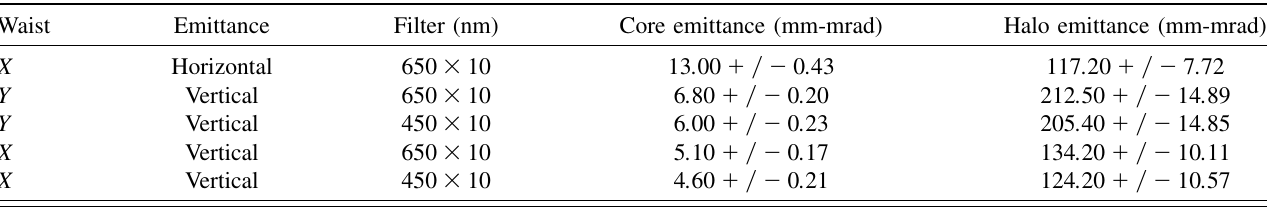
TABLE V. RMS horizontal and vertical emittances for the core and halo components measured at X and Y waist conditions. Waist Emittance Filter (nm) Core emittance (mm-mrad) Halo emittance (mm-mrad)